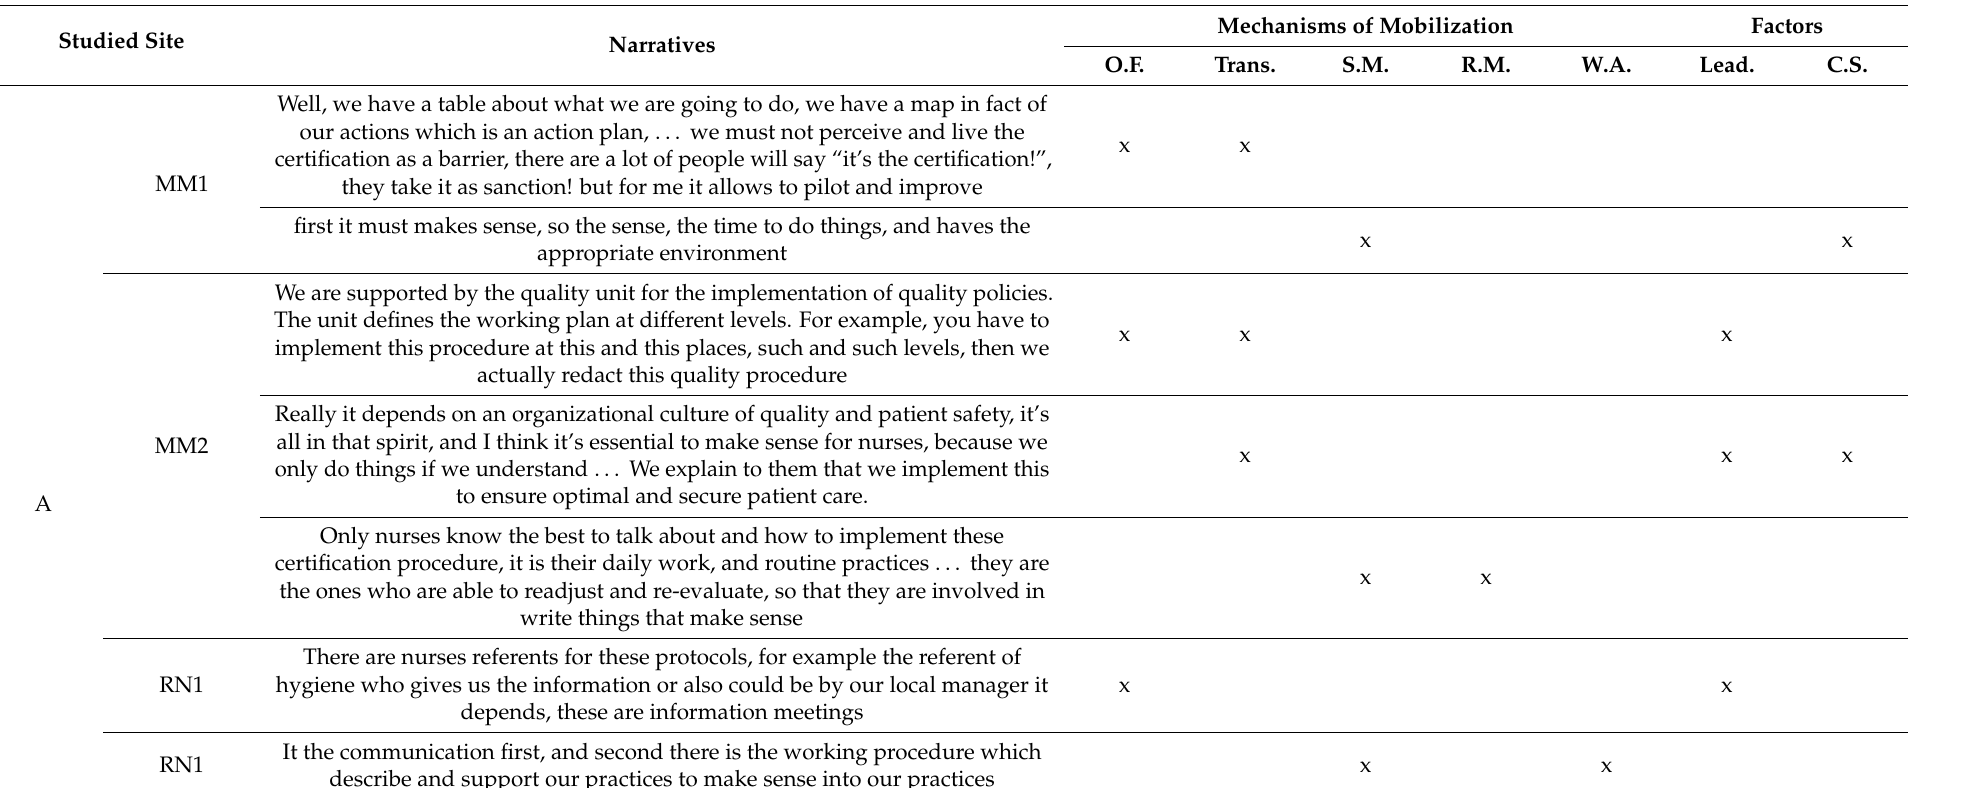
Table A2. IFINP components interferences. This table presents the analysis of interviewees’ narratives reflecting the interferences of INIFP components, mechanisms of mobilization, and factors. Retrieved elements simultaneously in each narrative are checked by